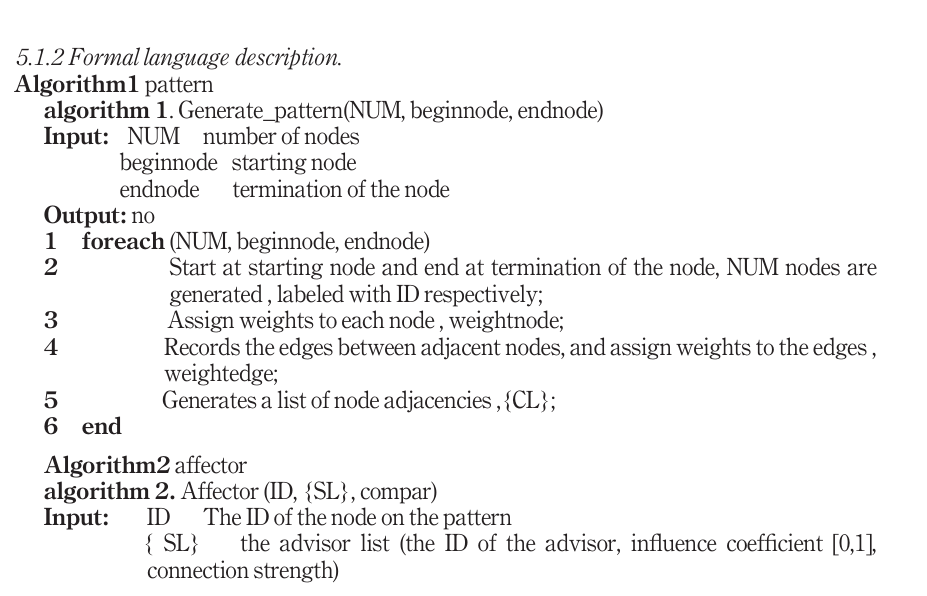
Figure 7. E-commerce system simulation